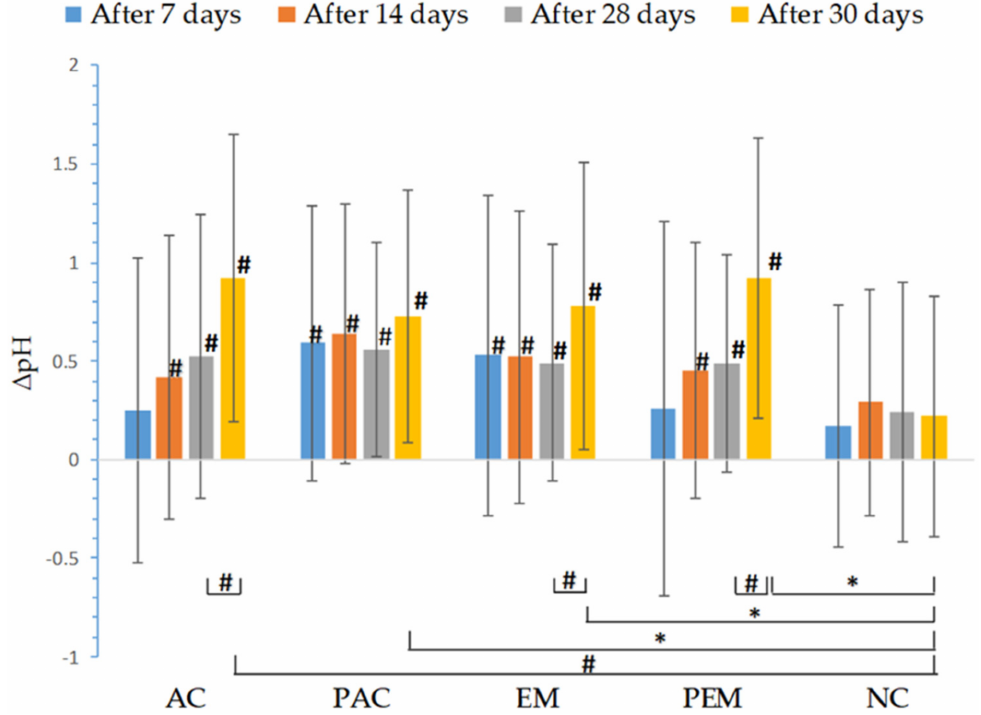
Figure 5. In vivo determined absolute changes relative to basal values of pH for investigated creams (active cream—AC, placebo cream—PAC) and emulgels (active emulgel—EM, placebo emulgel— PEM) after 7, 14, and 28 days of application, and 2 days after cessation of application. Significant differences are marked with # ( p < 0.01) and * ( p <